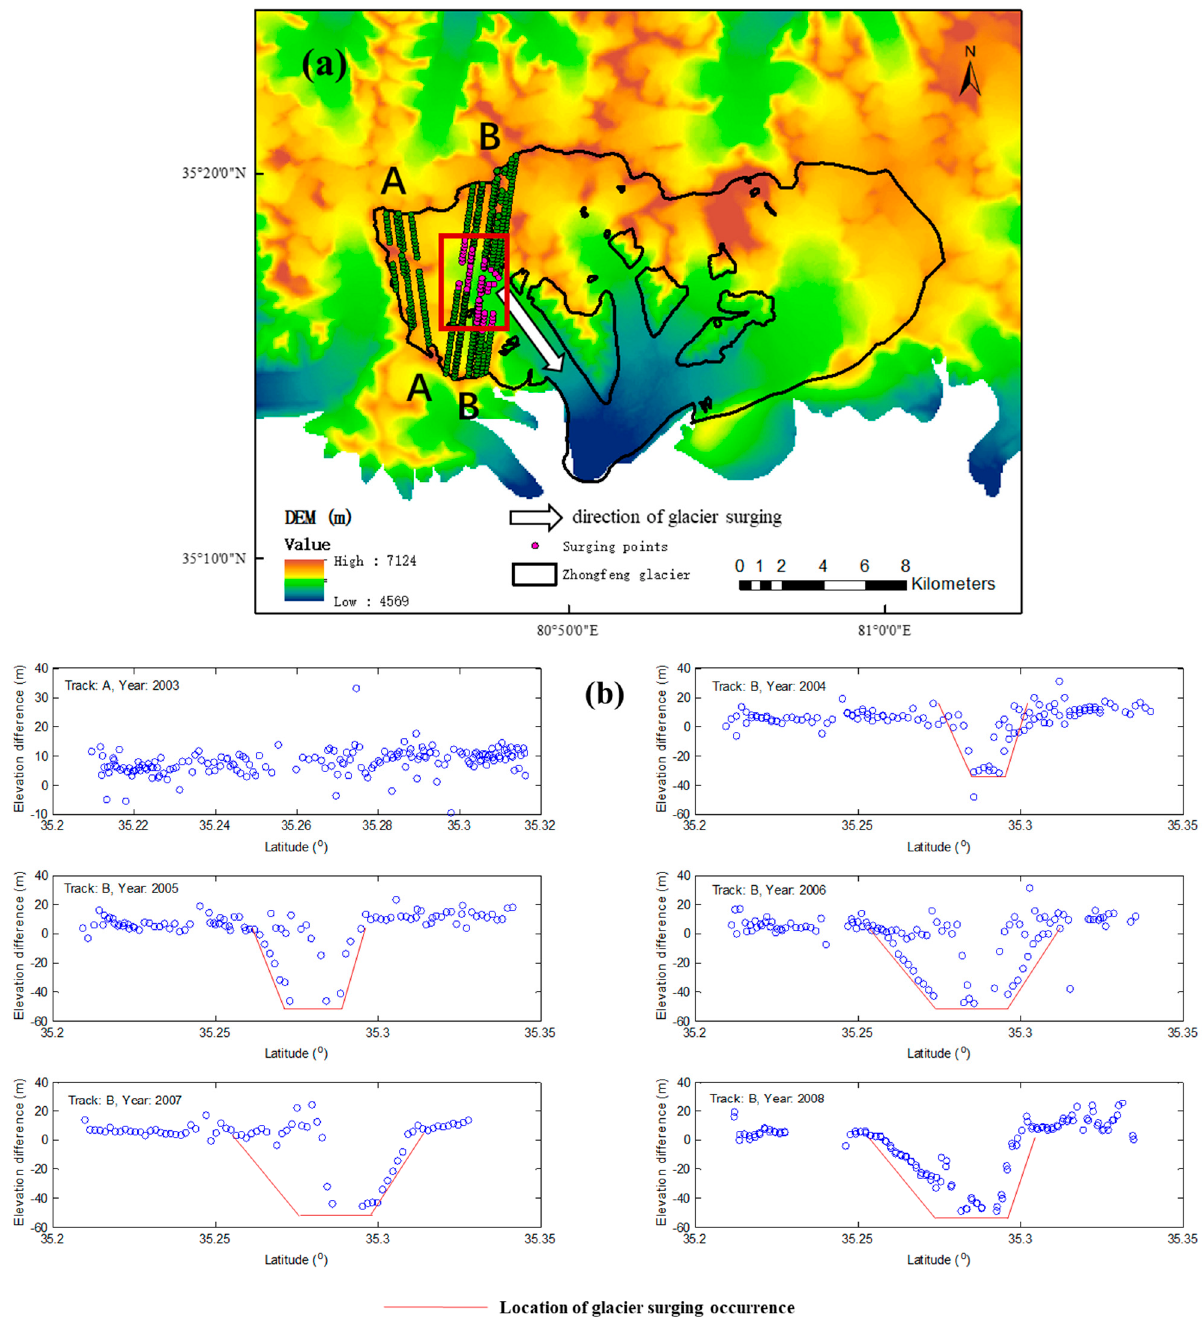
Figure 7. Surging Zhongfeng glacier laser coverage location and elevation time series. ( a ) ICESat data distribution over the accumulation area of Zhongfeng glacier; ( b ) drastic drop in elevation difference along the latitudinal profiles on Zhongfeng glacier.